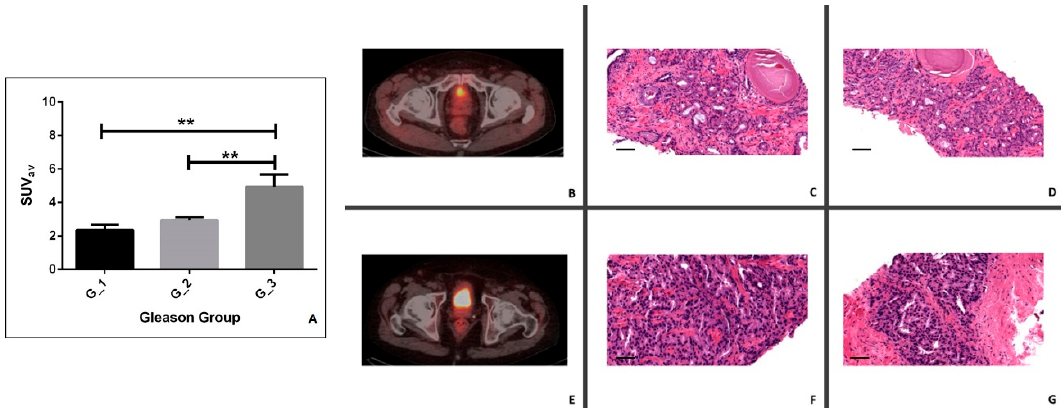
Figure 1. Comparison between Gleason Group (GG) and 18 F–choline uptake. ( A ) The graph shows the standardized uptake value (SUV) average in G_1, G_2, and G_3 groups. ( B ) A 66-year-old prostate cancer patient (Gleason group of 3 + 4, primary PSA level of 7.37 ng/mL). Transaxial 18 F–choline PET/CT image. ( C , D ) Prostate biopsy of lesion in panel B (Gleason Group 3 + 4). ( C ) Hematoxylin and eosin staining display a prevalent lesion with well-formed glands (Gleason score 3). ( D ) According to a Gleason score of 4, image shows poorly formed glands. ( E ) A 64-year-old prostate cancer patient (Gleason group of 4 + 4, primary PSA level of 11.25 ng/mL). Transaxial 18 F–choline PET/CT image. ( F , G ) Prostate biopsy of lesion in panel E showing a 4 + 4 Gleason Group. ( F ) Hematoxylin and eosin staining display a prevalent lesion with poorly formed glands (Gleason score 4). ( G ) Image shows poorly formed glands (Gleason score 4). Scale bar represents 50 μ m in each image. * p < 0.05, ** p < 0.01, *** p <